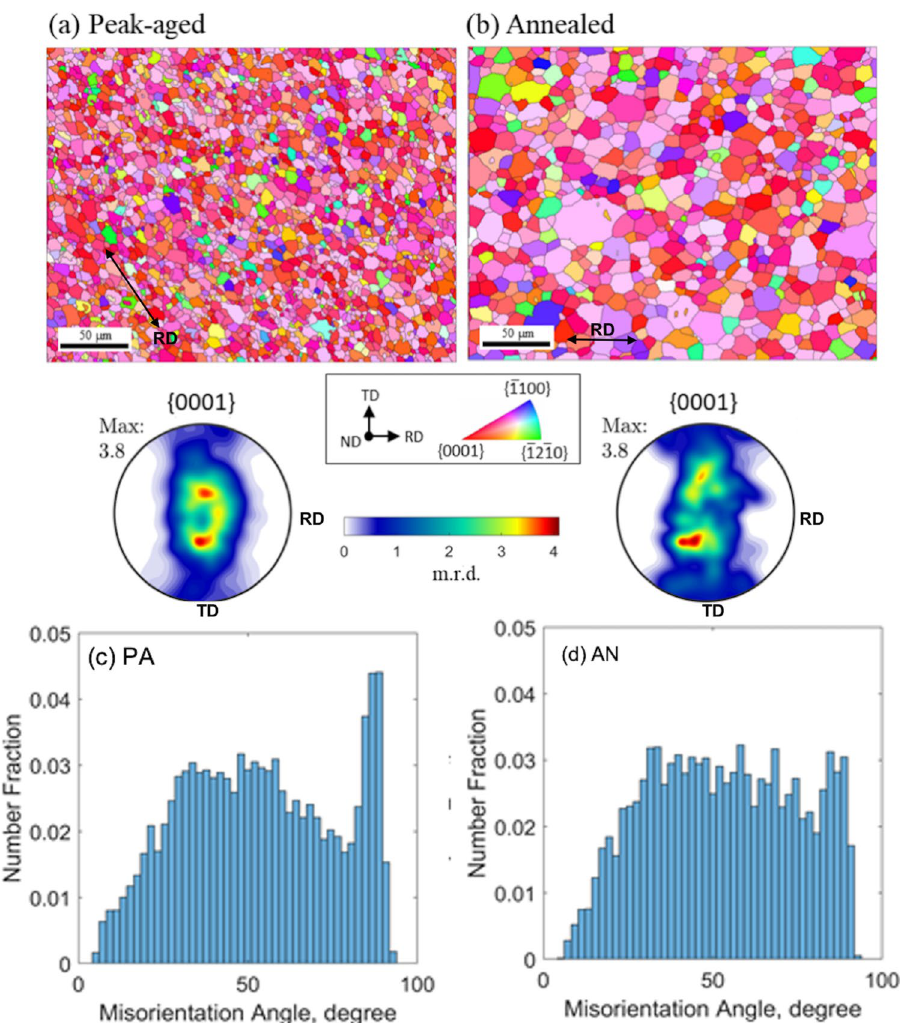
Figure 2. Inverse pole figure maps of the mean grain orientations and pole figures constructed from the EBSD data of the ( a ) peak-aged (PA) material and ( b ) annealed (AN) material. These confirm the dominance of the (0001) basal plane for both materials. There is a slight spread in the basal poles along the transverse direction as well as much larger grain sizes for the ( b ) AN material. The misorientation angle distributions for the ( c ) PA and ( d ) AN